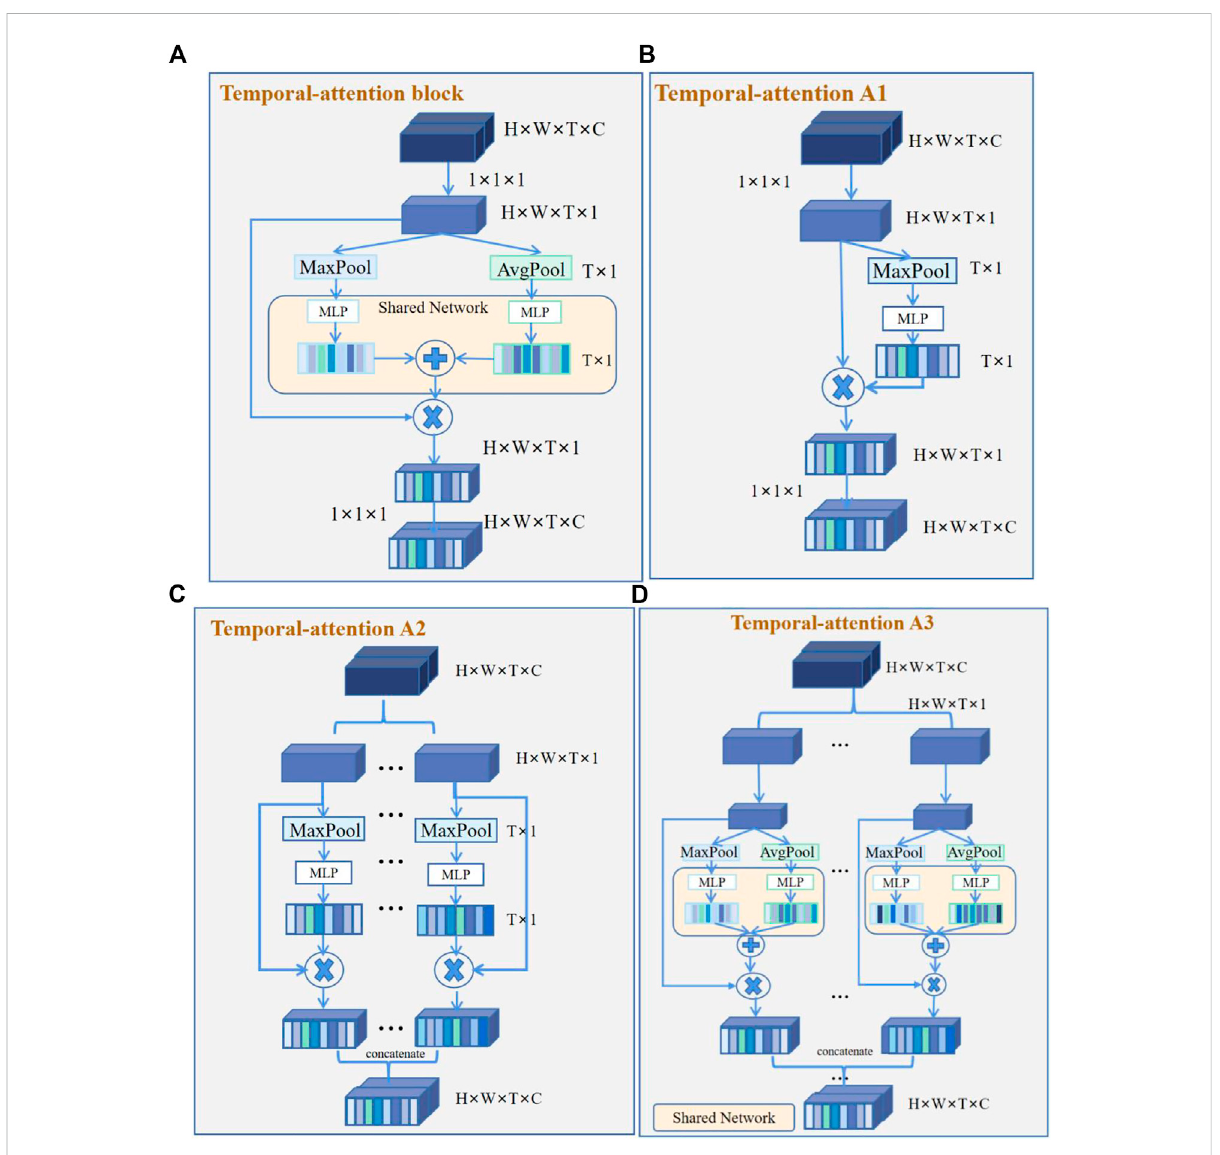
FIGURE 3 Temporal-attention block and its variants. (A) Temporal-attention block. Two groups of features were obtained by global average pooling (AvgPool) and maximum average pooling (MaxPool), then get the sum of the different features matrices. (B) Temporal-attention A1. Feature acquisitioncontains only MaxPool. (C) Temporal-attentionA2. Different channel features were obtained byMaxPool, and use concatenation to fuse different channel features. (D) Temporal-attention A3. Different channel features were obtained by AvgPool and MaxPool, and use concatenation to fuse different channel